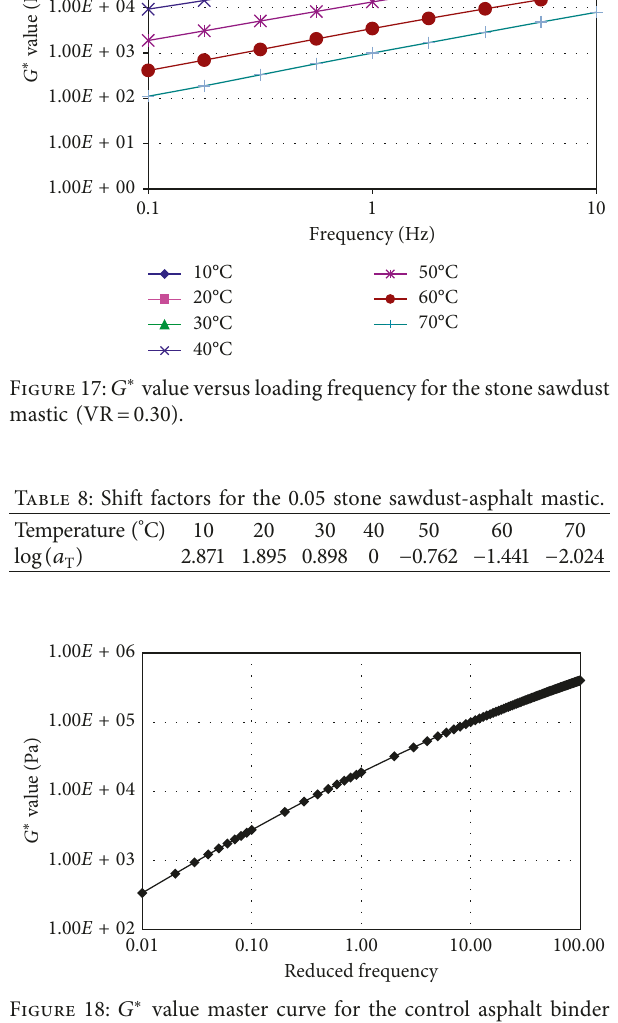
Figure 18: G value master curve for the control asphalt binder (VR 0.00). ∗ (cid:30)